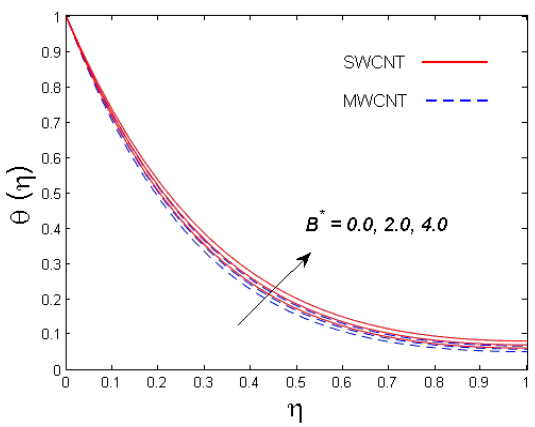
Figure 13. The illustration of B * versus θ ( η ).